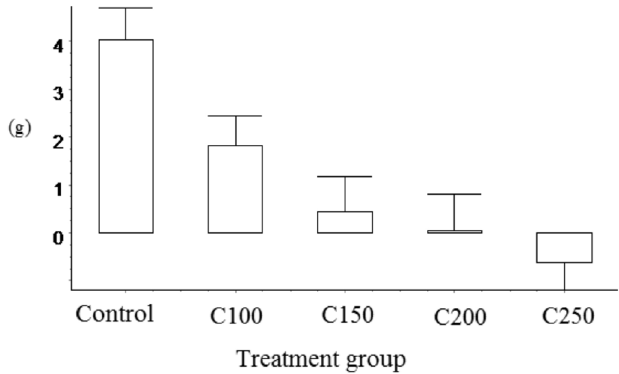
FIGURE 1 – Body mass variation in male mice treated with different concentrations of cyclophosphamide, for 6 weeks.